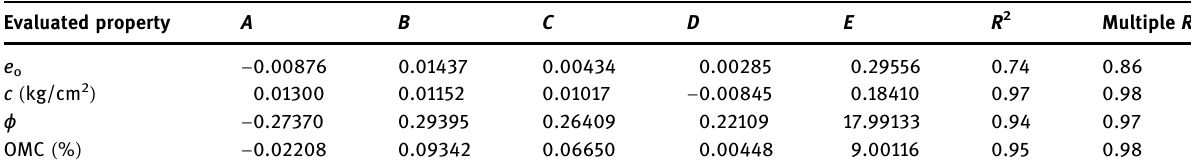
Table 4: Linear multi - regression idealization for various soil characteristic for Kirkuk city Evaluated